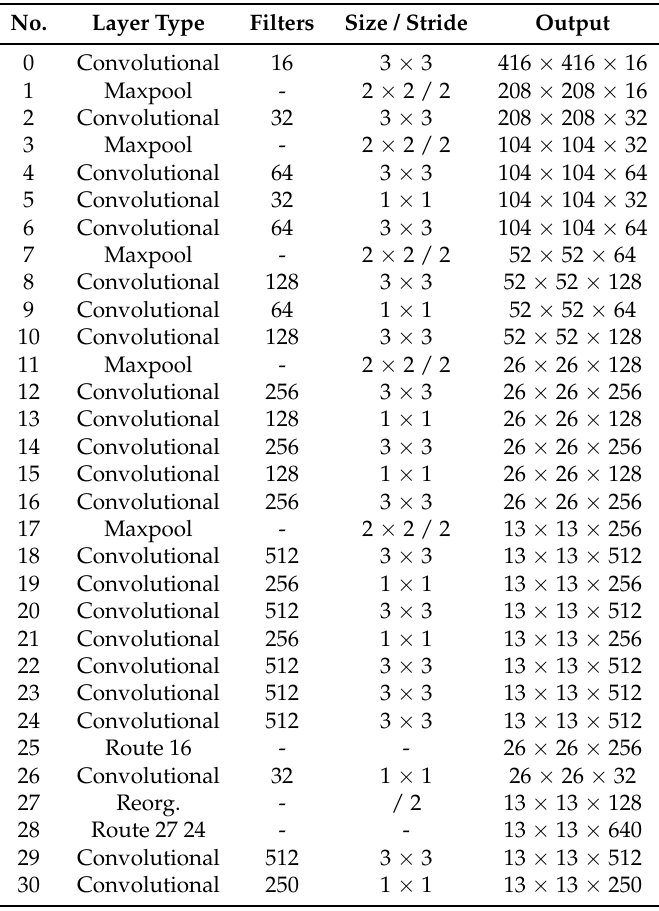
Table 2. Modified YOLOv2 model